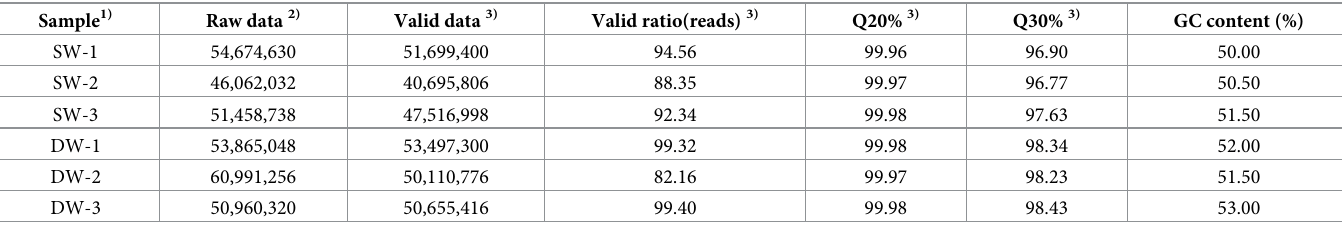
Table 5. Summary statistics of the sequencing